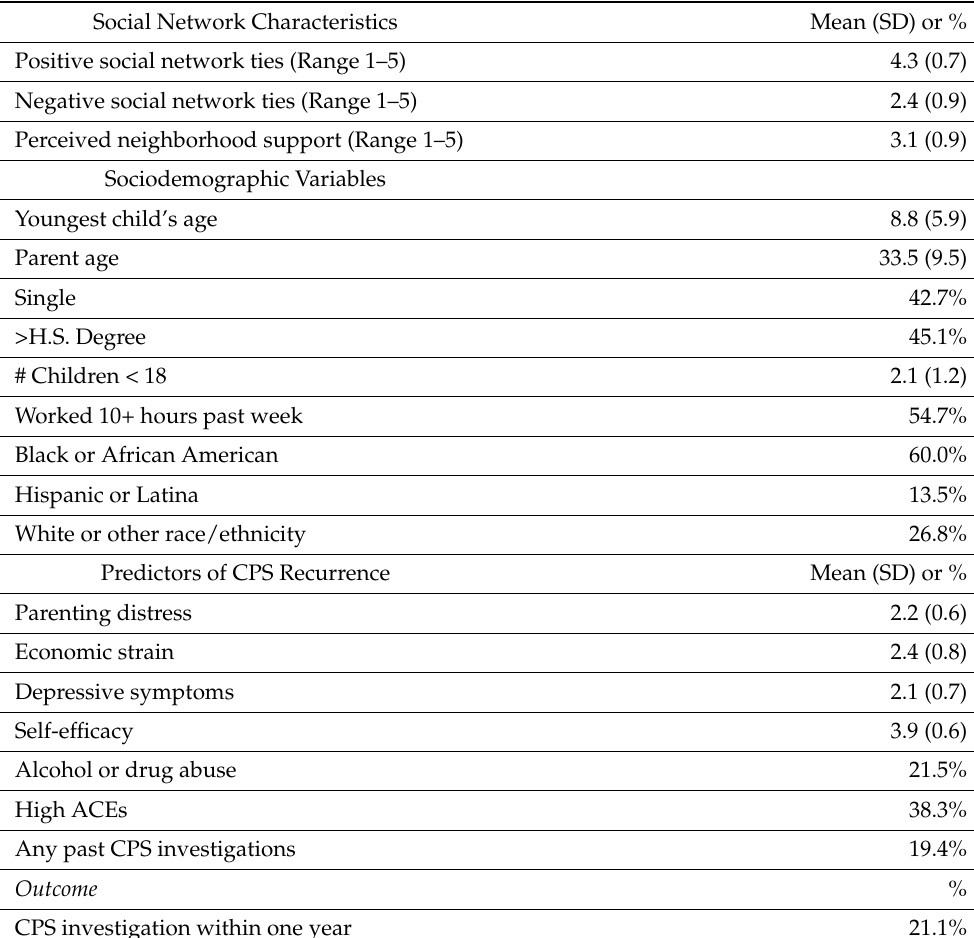
Table 1. Sample Descriptives (N =